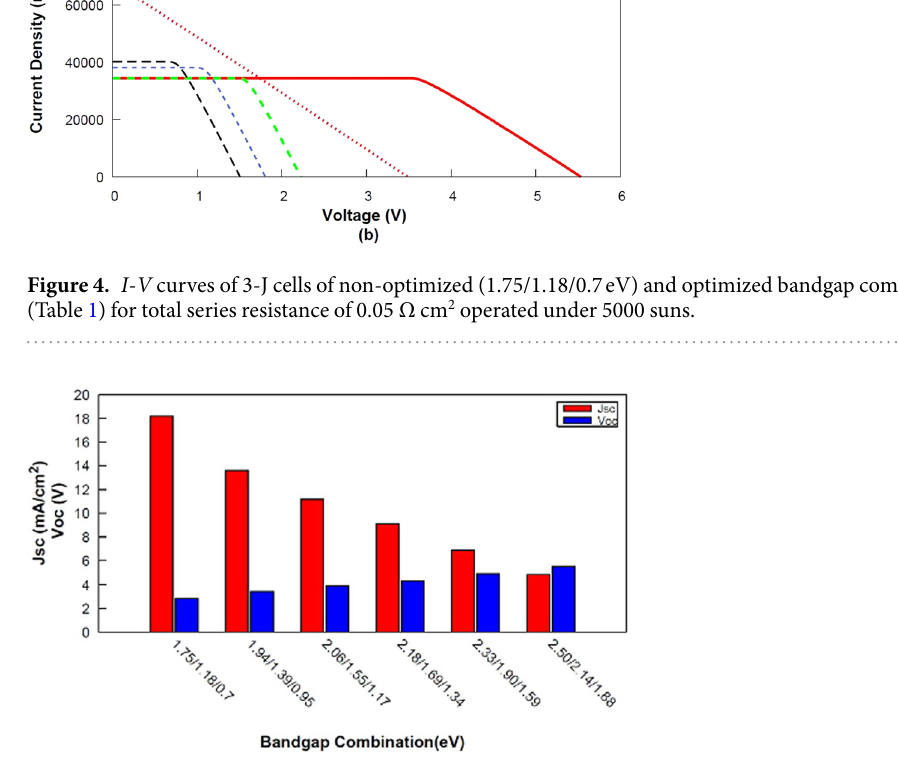
Figure 5. Evolution of J sc and V oc for different combination of bandgaps (Table 1) under an illumination of 1